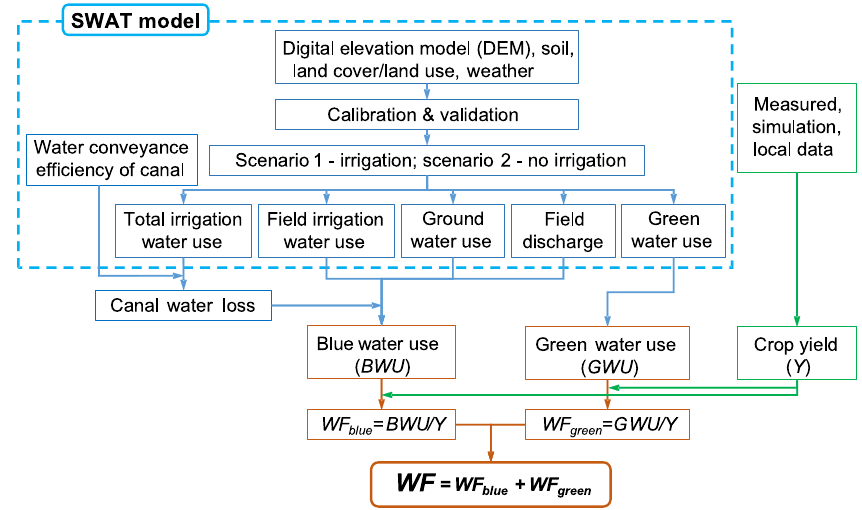
Figure 3. The flow chart for calculating the regional-scale water footprint.